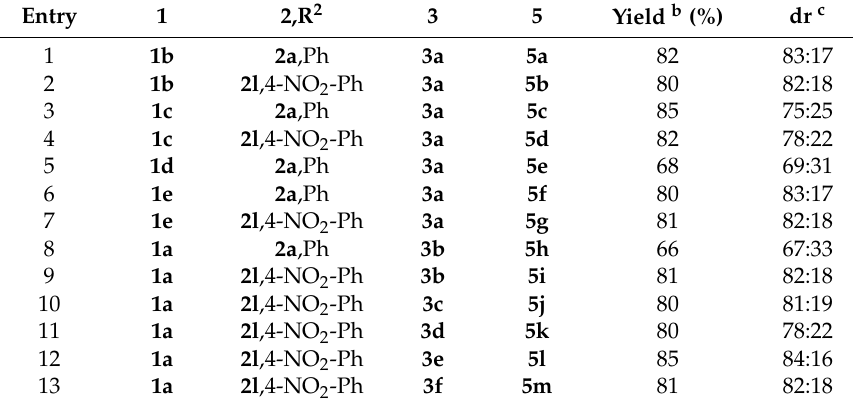
The relative configuration of 1,3-dipolar cycloaddition product 4k was established by X-ray diffraction analysis (Figure 2) [22], the relevant data shown in Supplementary Materials and the relative configurations of other succinimide-fused spiro[pyrrolidine-2,3 (cid:48) -oxindole] products were assigned by analogy.